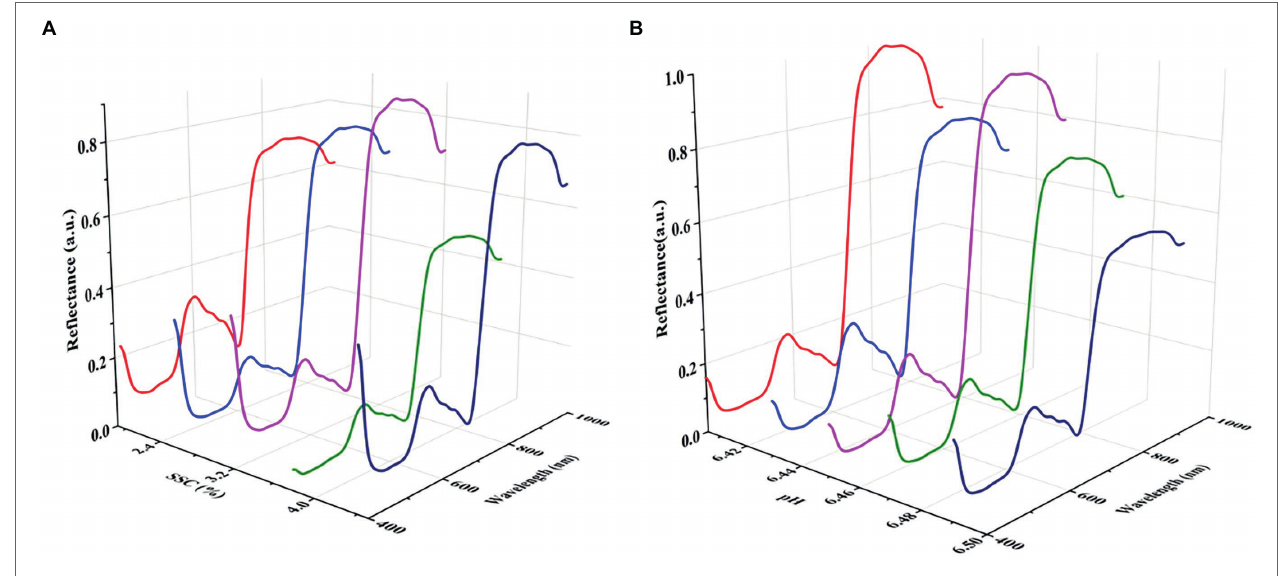
FIGURE 6 | Mean spectral reflectance of plants of different SSC (A) and pH (B) .